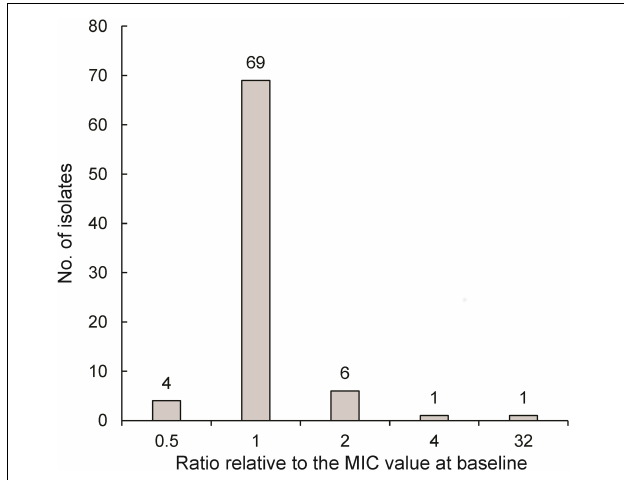
FIGURE 3 | MIC change after LZD exposure ( N = 81). The horizontal axis represents the ratio of MIC value of the most recently tested isolate prior to culture conversation relative to the MIC value at baseline.